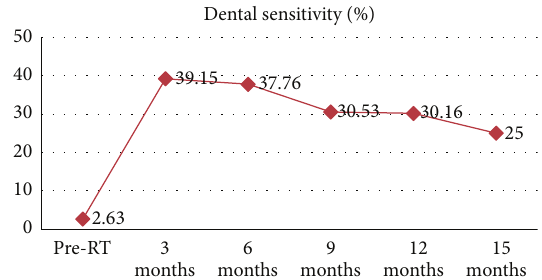
Figure 1: Graph showing dental sensitivity at each followdup visit after FVA.